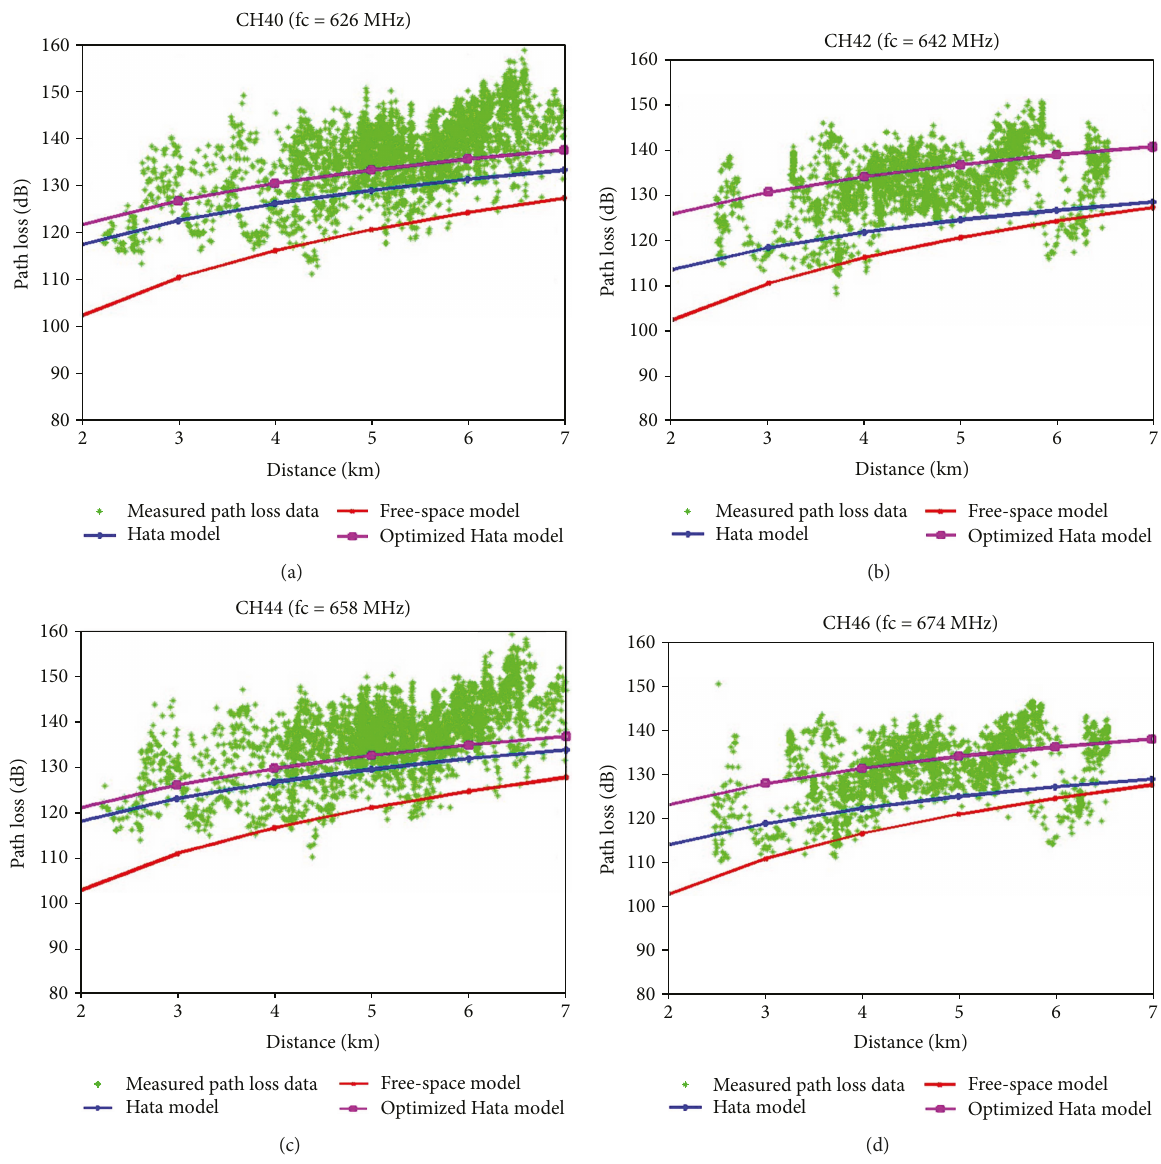
Figure 6: Measurement data of path loss curves between Songkla and Surathani